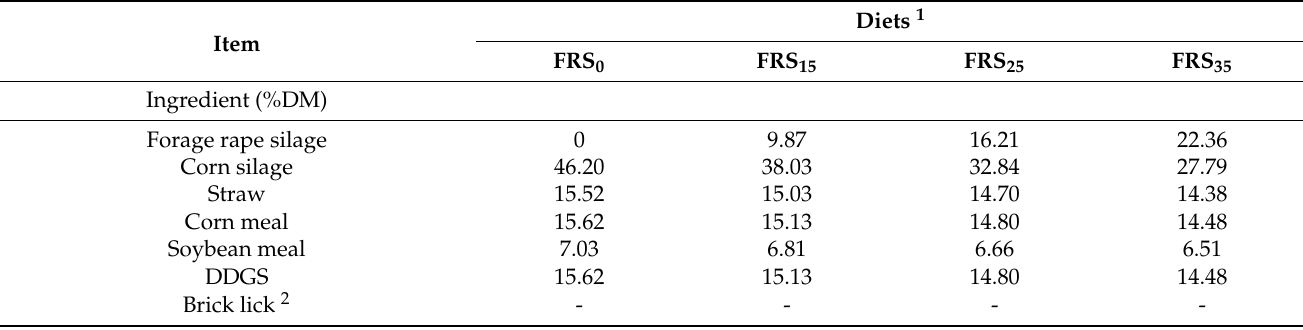
Table 2. Ingredients and chemical composition of the experimental